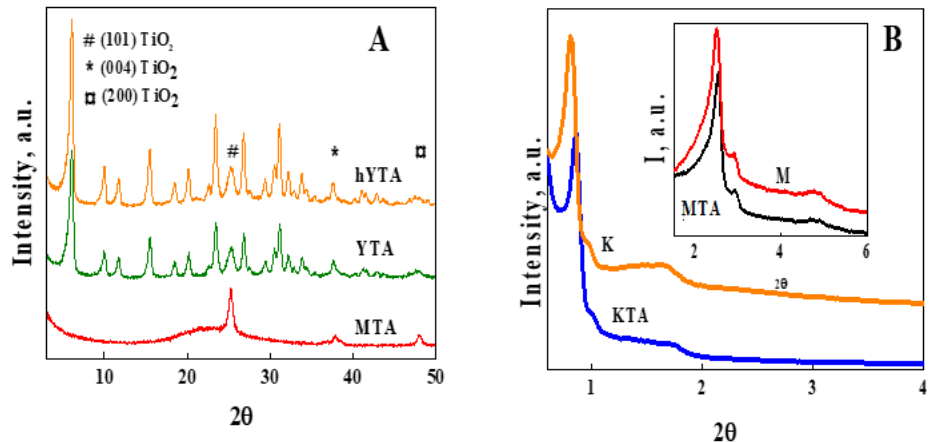
Figure 1. XRD patterns at wide angle ( A ) and low angle ( B ) of synthesized materials. One can notice that gold-based compounds were not identified in the XRD